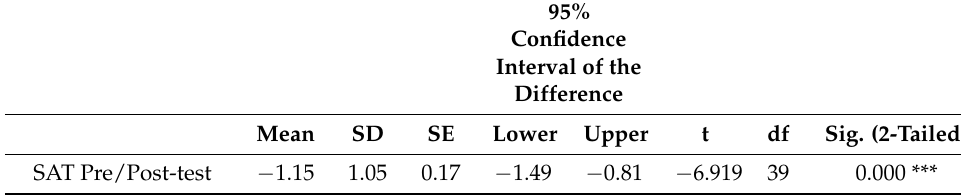
Table 10. Paired sample test of SAT.